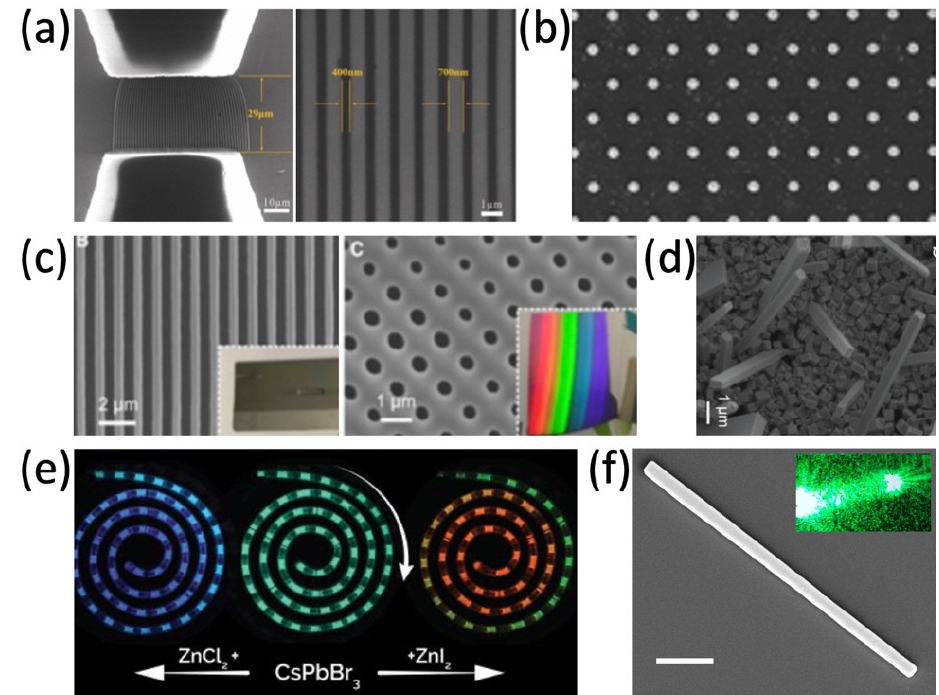
Figure 2. ( a ) SEM images of the silicon nanowire template for microfluidic synthesis. Adapted with permission from Ref. [45]. Copyright 2020 The Royal Society of Chemistry. ( b ) SEM image of the